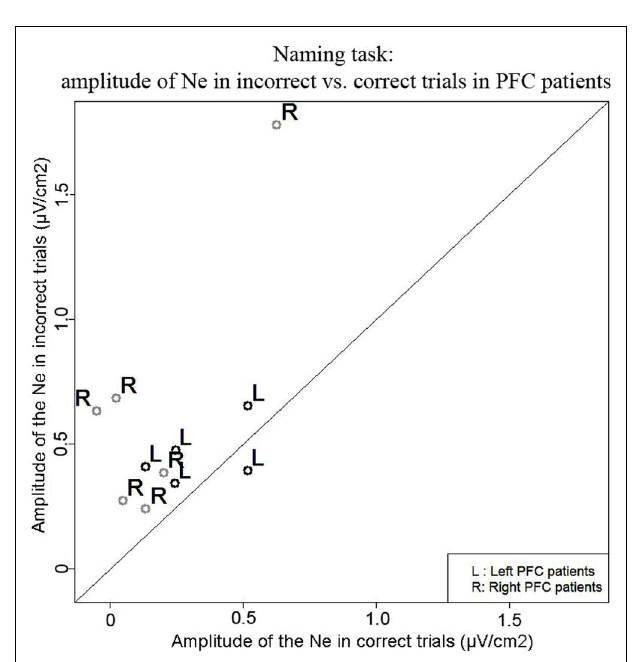
(from − 20 to 20 ms after vocal onset). A 100 ms-long baseline was taken between 200 and 100 ms before vocal onset.The scale used for the topography for correct trials was larger than the one used for incorrect trials as the amplitude of the Ne was smaller in correct trials than in errors.